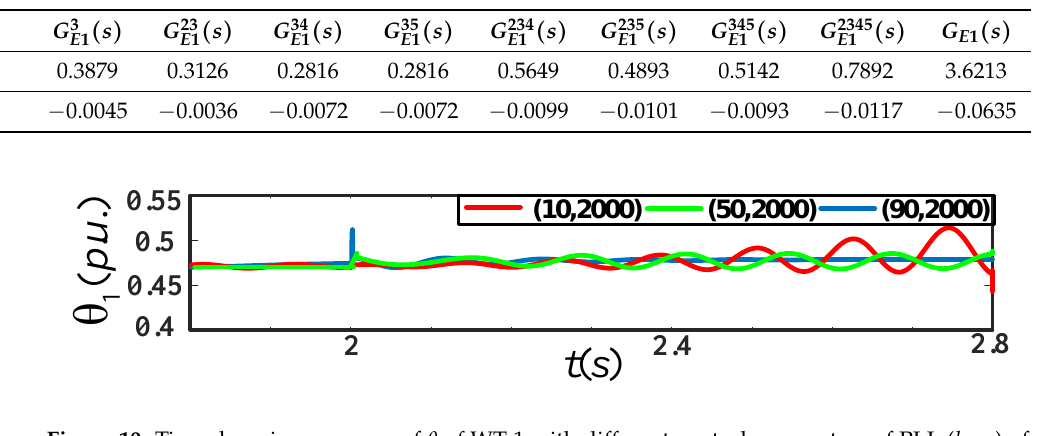
Figure 10. Time domain responses of θ of WT 1 with different control parameters of PLL ( k P 23 ) of WT 3.